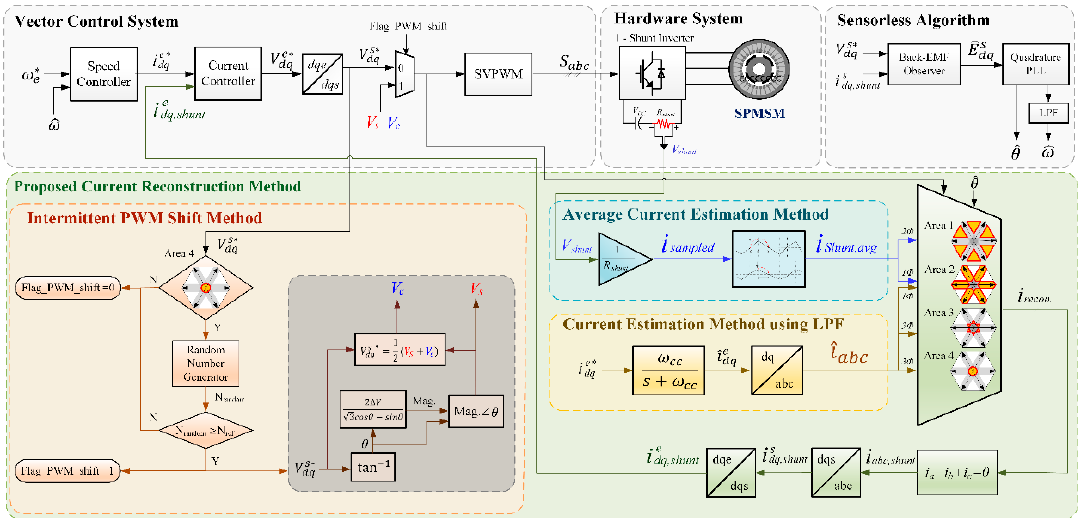
Figure 10. Block diagram of the proposed current reconstruction method in all operation regions.